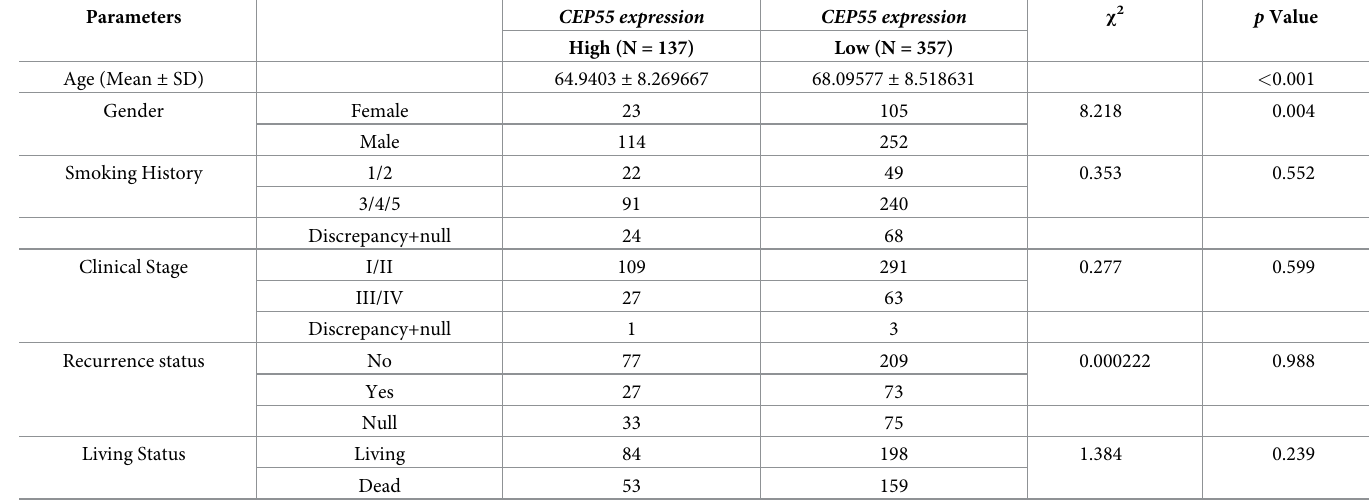
Table 2. The association between CEP55 expression and the demographic and clinicopathological parameters of patients with primary LUSC in TCGA. Parameters